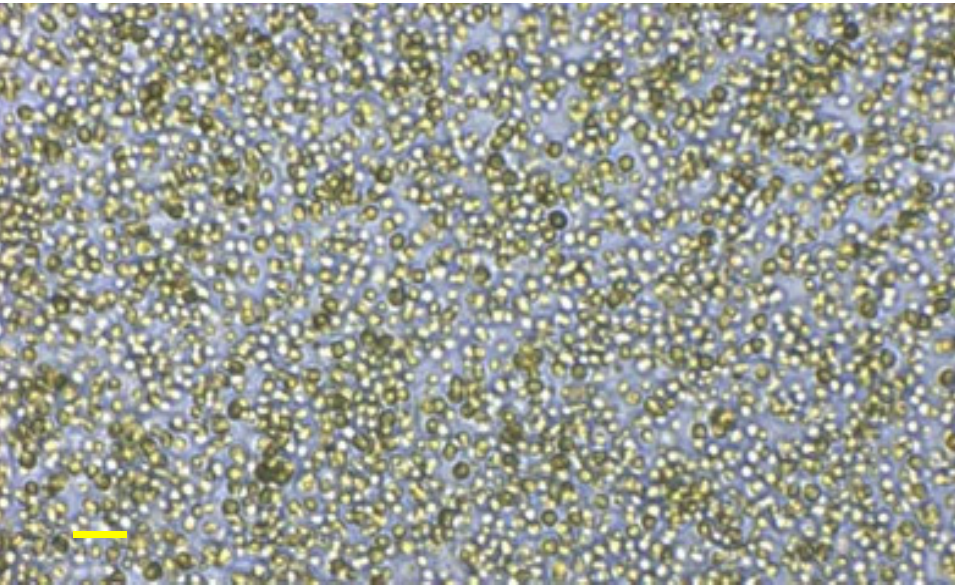
Figure 1. Intact cell wall of Nannochloropsis oceanica under brightfield microscopy. Scale bar is 10 µm (10×). Table 1. Nutrient composition of Nannochloropsis oceanica algae powder.